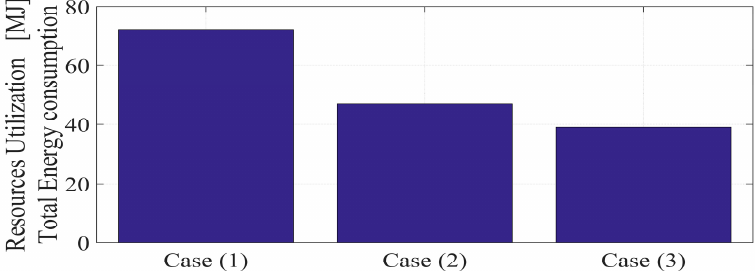
Figure 9. The average resources utilization in terms of energy for the considered simulation cases.